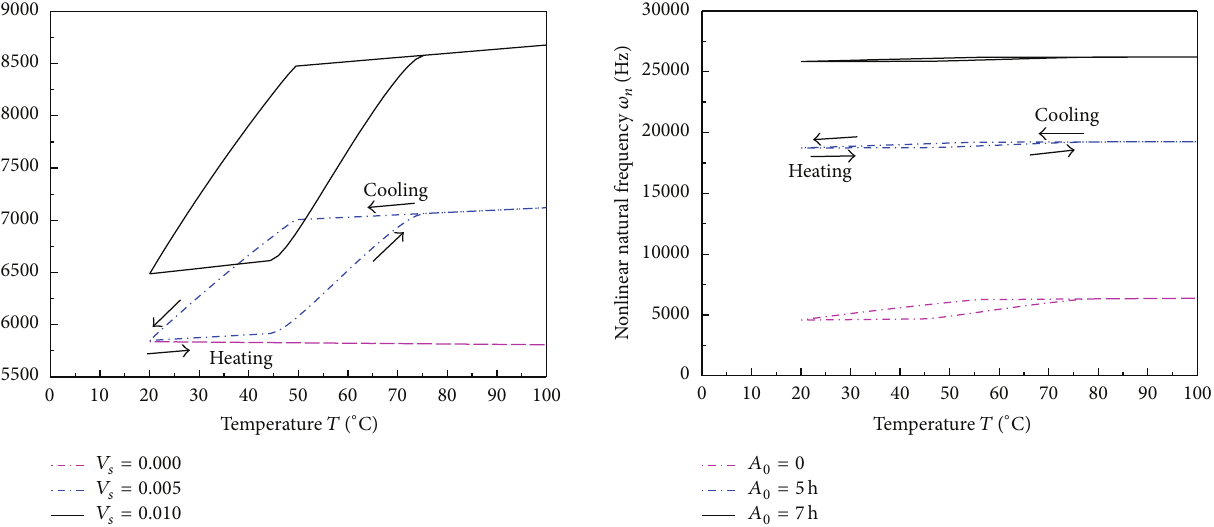
Figure 11: Variation of the nonlinear natural frequency with the actuation temperature for different 𝑉 𝑠 ( 𝜀 0 = 0.03 , 𝐴 0 /ℎ = 1 , and 𝐿/ℎ = 10 ).